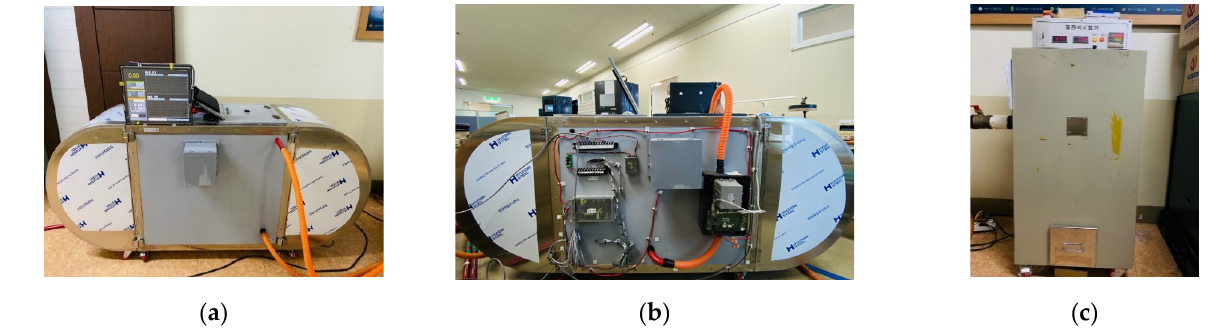
Figure A3. The smokebox system ( a ) The smokebox and computer (front view); ( b ) The smokebox, computer and ASD 2 (back view); ( c ) The smoke generator.